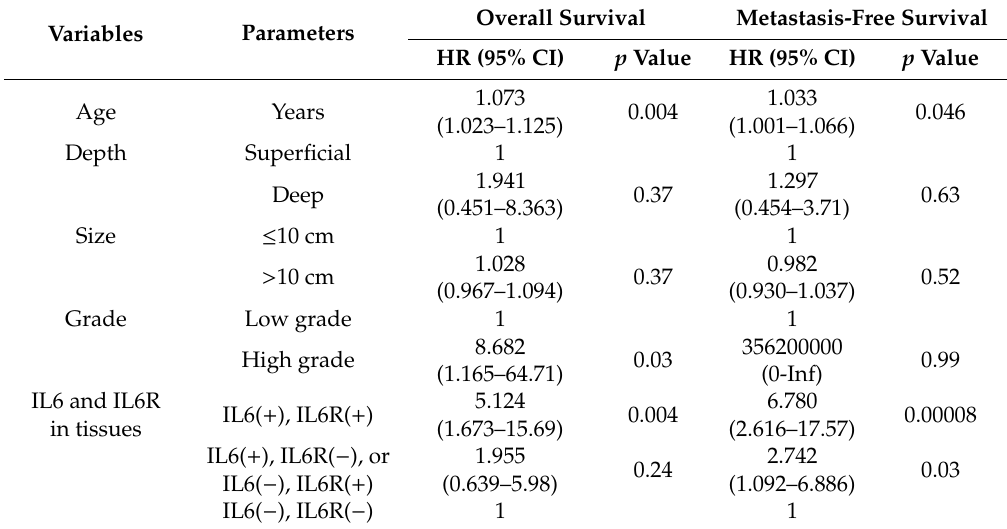
Table 3. Univariate cox population hazard analysis for overall survival and metastasis-free survival.